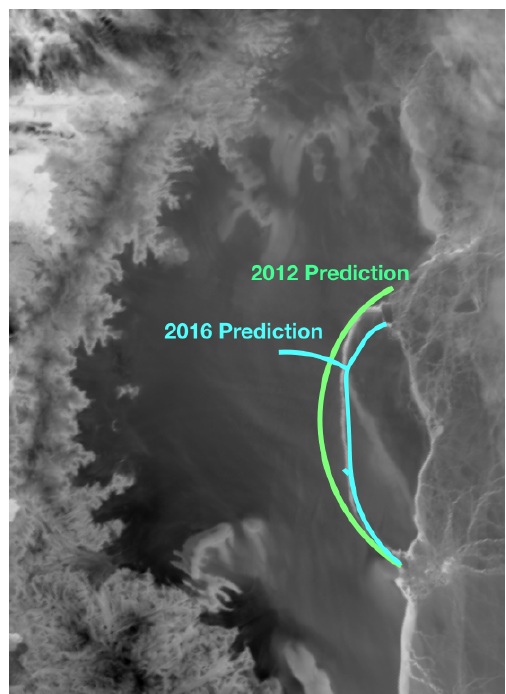
Figure 8. The 2012 prediction based on ice surface velocity data, and the 2016 prediction based only on satellite images, compared to the actual crack (white curve between the two prediction curves) on July 2017, as shown in Fig. 1. Raw image sourced from Scambos et al.